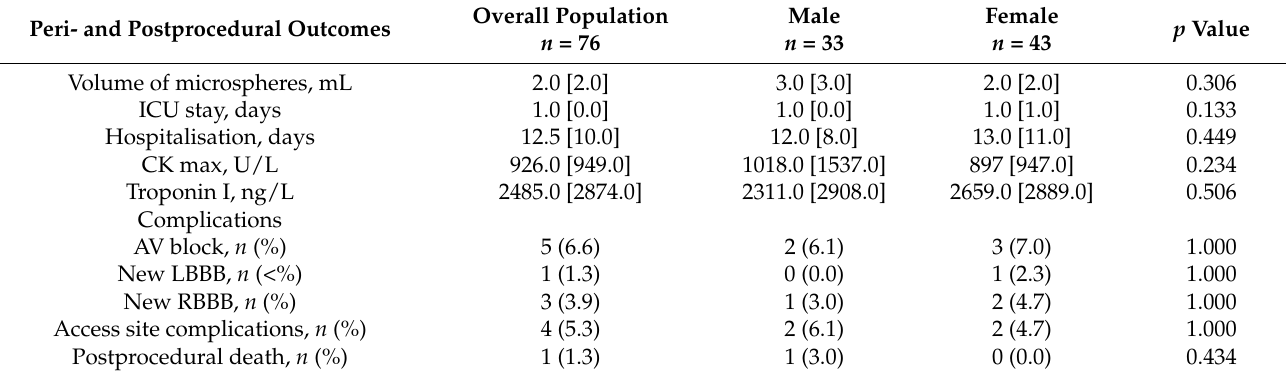
Table 2. Procedural characteristics and complications.